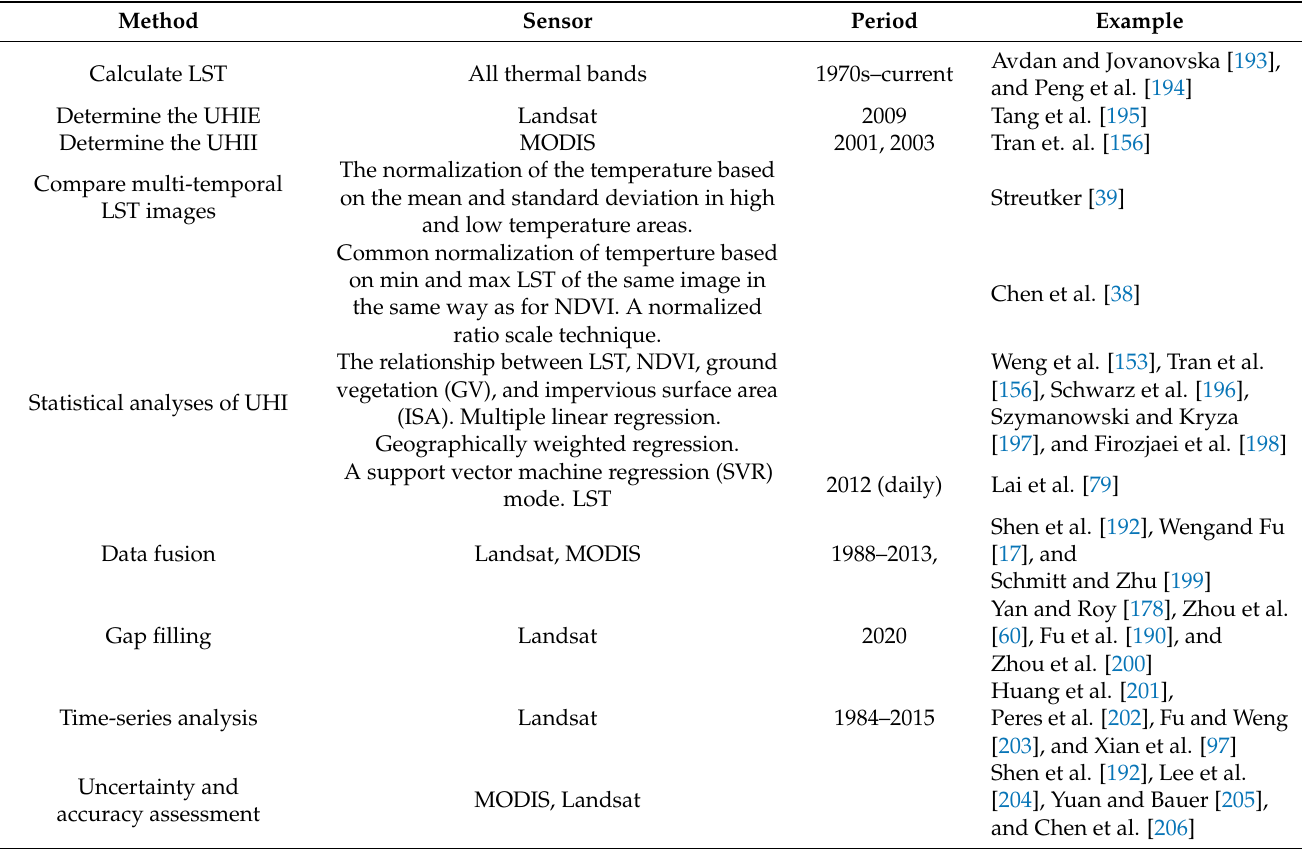
Table 5. Methods used to measure UHI and UHIRIP using remotely sensed